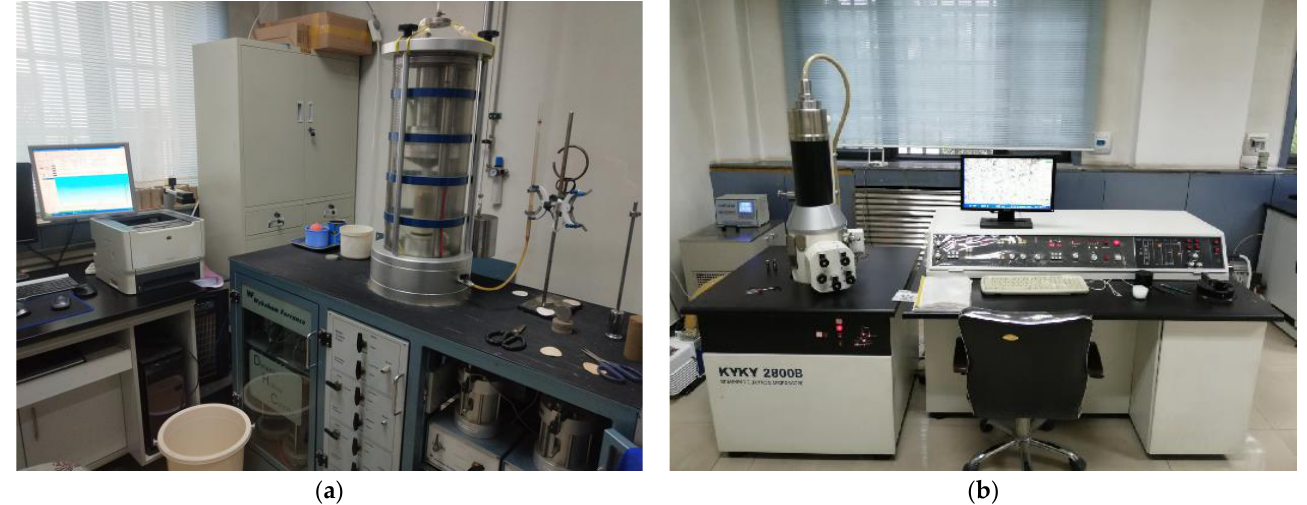
Figure 5. Test instruments: ( a ) the WF-12440 dynamic triaxial torsional shear test system, and ( b ) the KYKY-2800B scanning electron microscope.